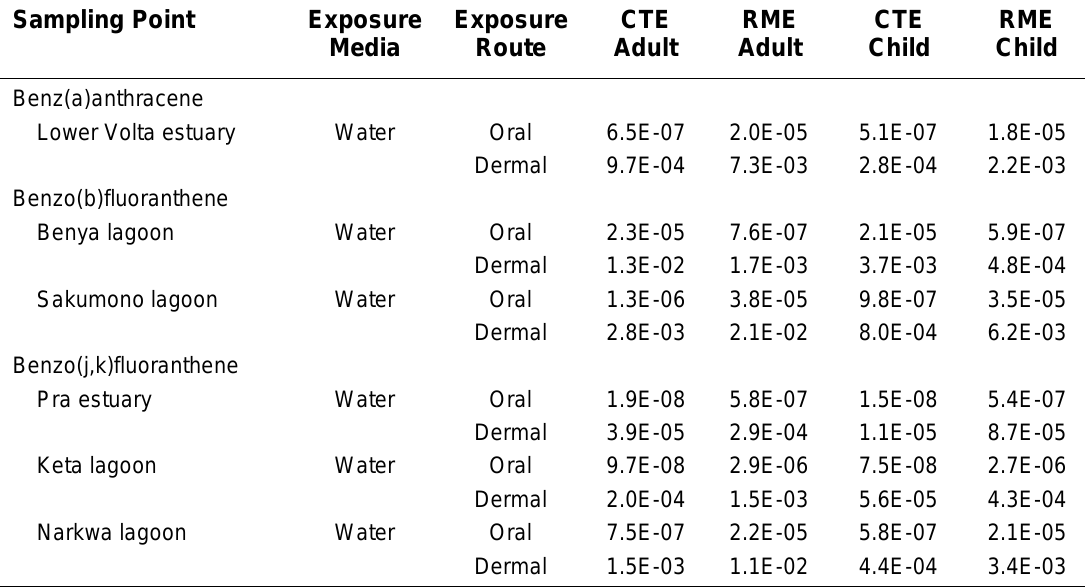
The Result of the Human Health Cancer Risk